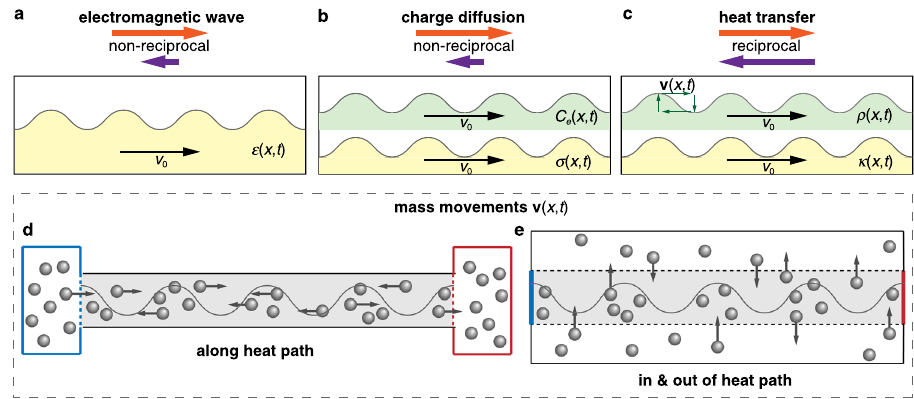
Fig. 1 Transport processes in dynamic materials under time modulation. a Non-reciprocal propagation of electromagnetic wave can be induced by spatial-temporally modulating the electric permittivity ε ( x , t ) as a traveling wave (with speed v 0 ). b Non-reciprocal diffusion of electric charges can be induced by spatial-temporally modulating the capacitance C e ( x , t ) and electric conductivity σ ( x , t ). c The reciprocity of heat transfer cannot be broken by modulating the density ρ ( x , t ) and thermal conductivity κ ( x , t ) since it is preserved by the continuity equation. Following the law, mass movements v ( x , t ) (green arrows) must exist to achieve density modulation. d , e Two types of mass movements (dark gray spheres): d along the heat transfer path (gray region). e moving in and out of the heat transfer